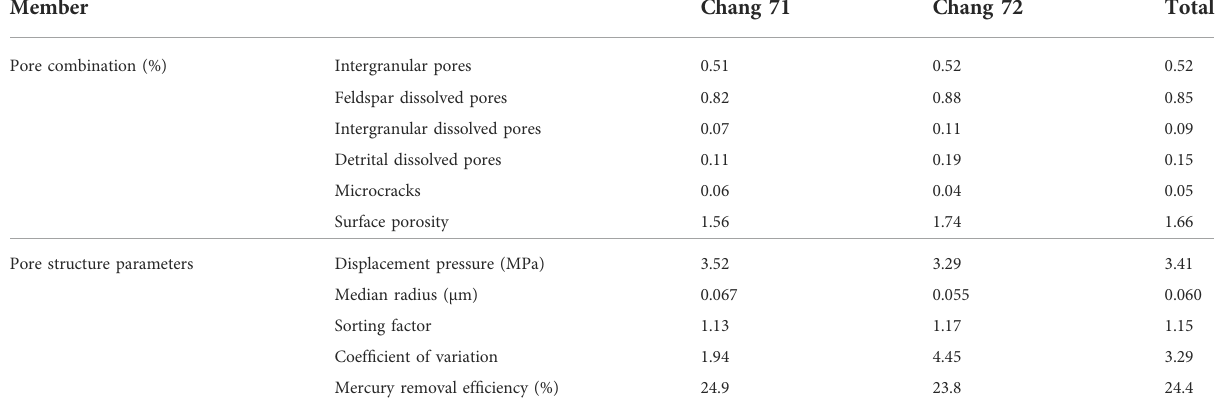
TABLE 1 Pore types and pore structure parameters of reservoirs in the Chang 7 Member in the study area. Member Pore combination (%)